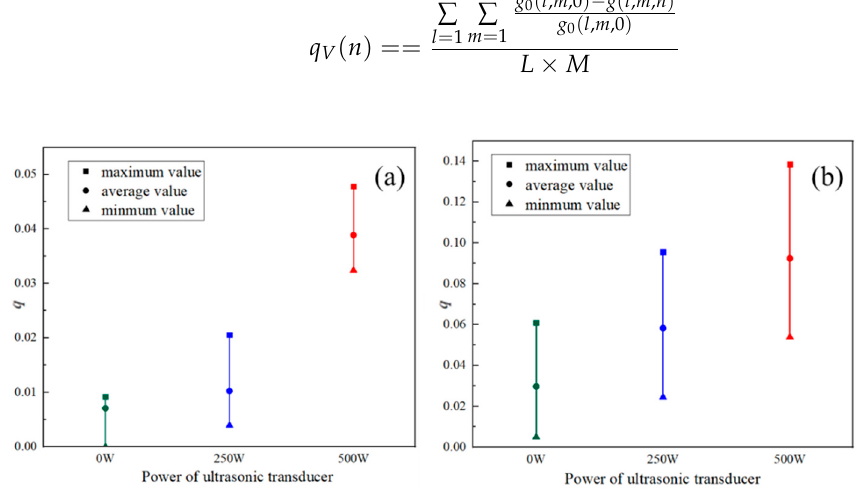
Figure 8. Volume-averaging cavitation intensity variable of cavitation ( a ) 1.5 MPa ( b ) 2 MPa.